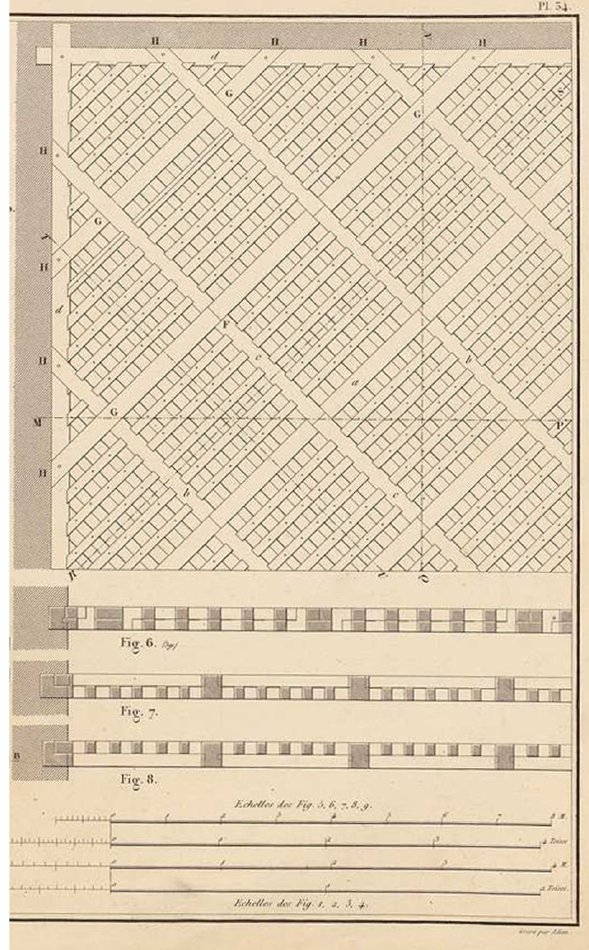
Figure 3: Table 34 of Emy’s Treatise: the Corbeil floor